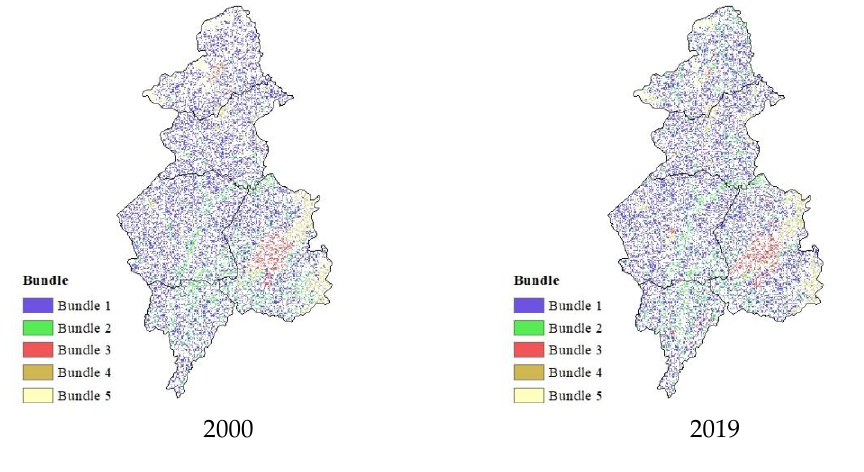
Figure 7. Predicted ES bundles.